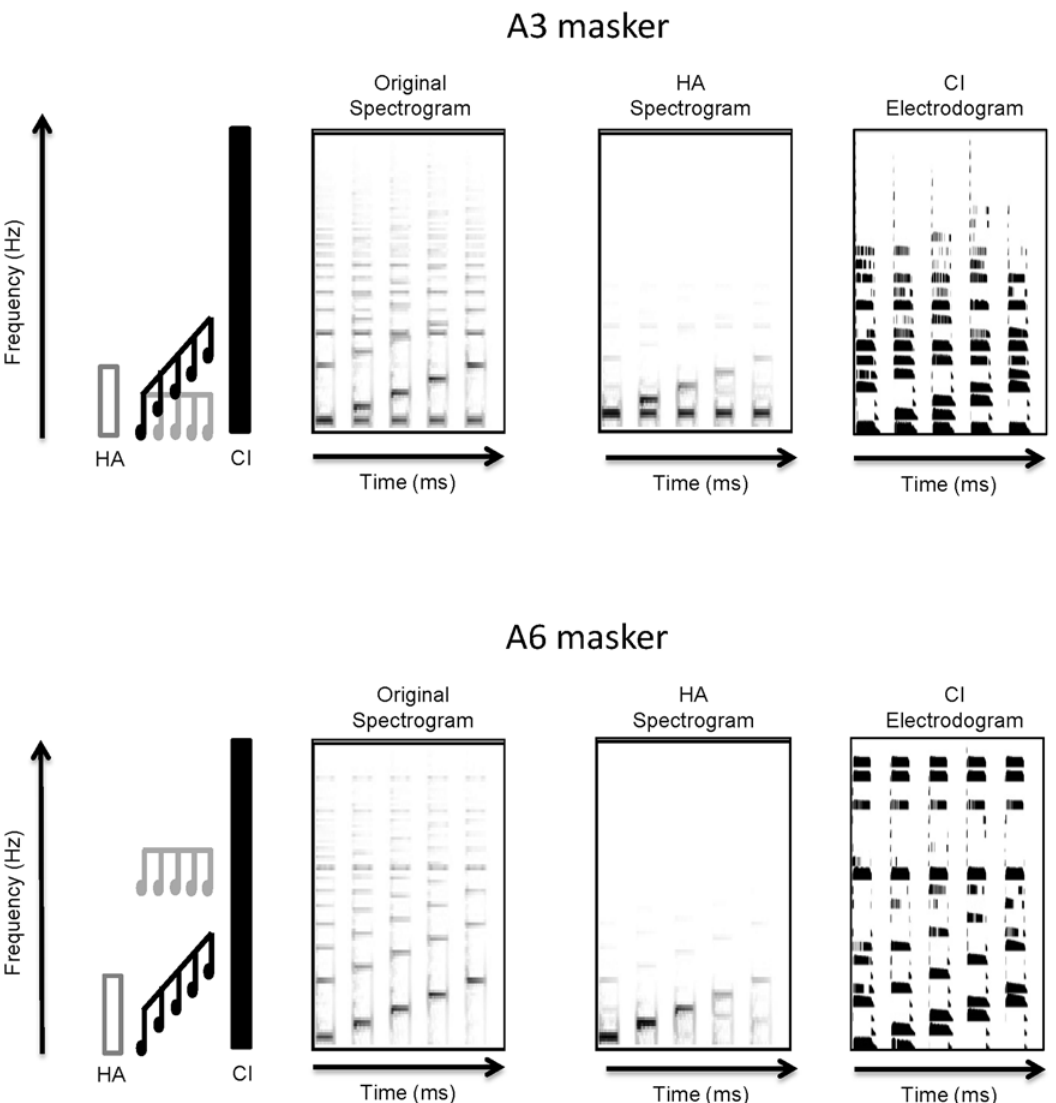
Fig 3. Spectrograms and electrodograms for the A3 and A6 Masker conditions. The top half of the figure shows (from left to right) a schematic representation of the test condition in relation to the frequency ranges of the HA and the CI, a spectrogram of the original stimuli, a spectrogram of the simulated HA output, and an idealized electrodogram for the A3 Masker condition; the bottom half shows the same information for the A6 Masker condition. Figure details are similar to the details of Fig. 2. The target instrument notes are shown in black and the masking instrument notes are shown in gray.